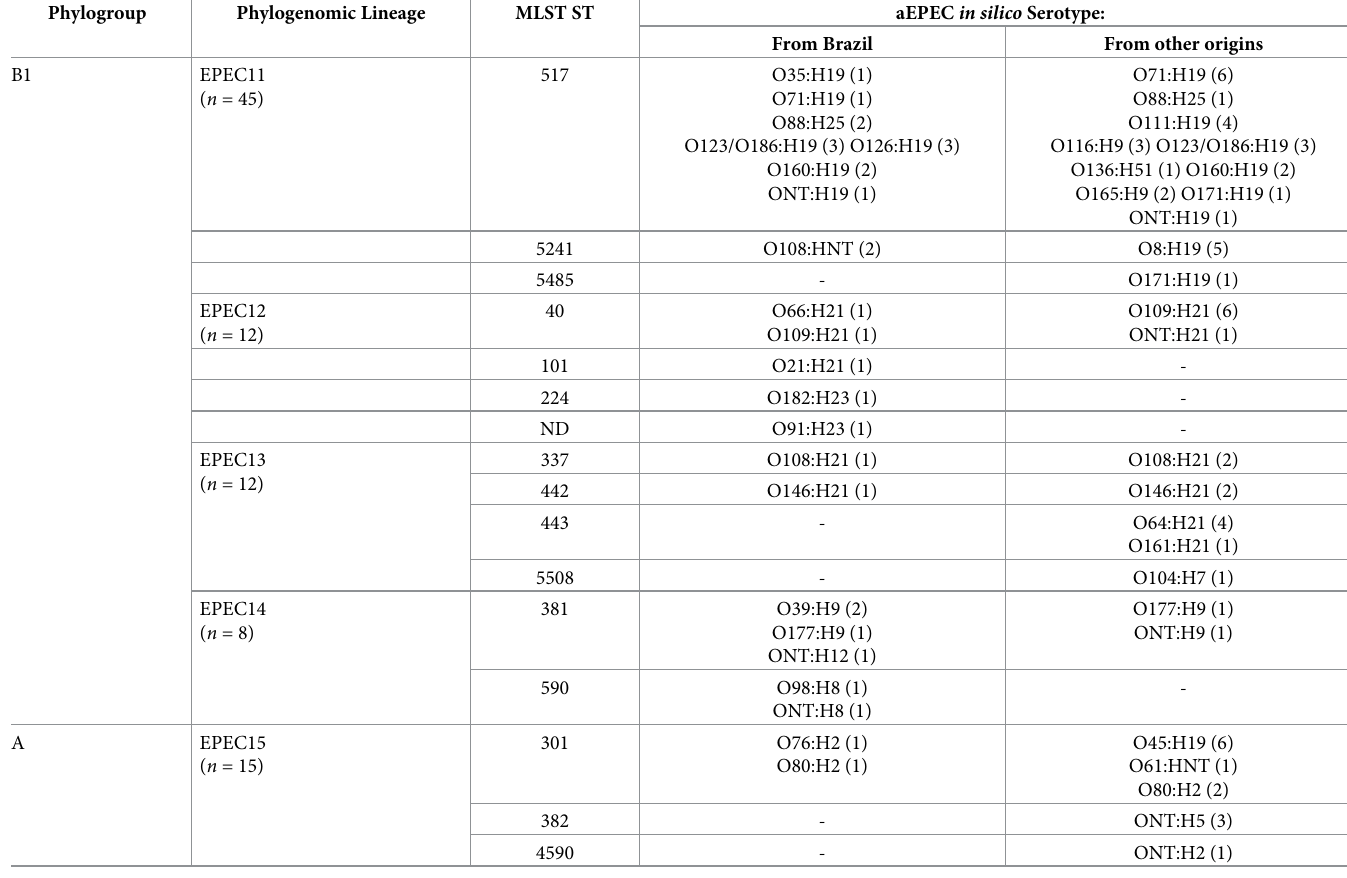
Table 3. Serotypes and Multilocus sequence typing (MLST) of the aEPEC isolates classified in the five novel phylogenomic lineages of EPEC described in this study.